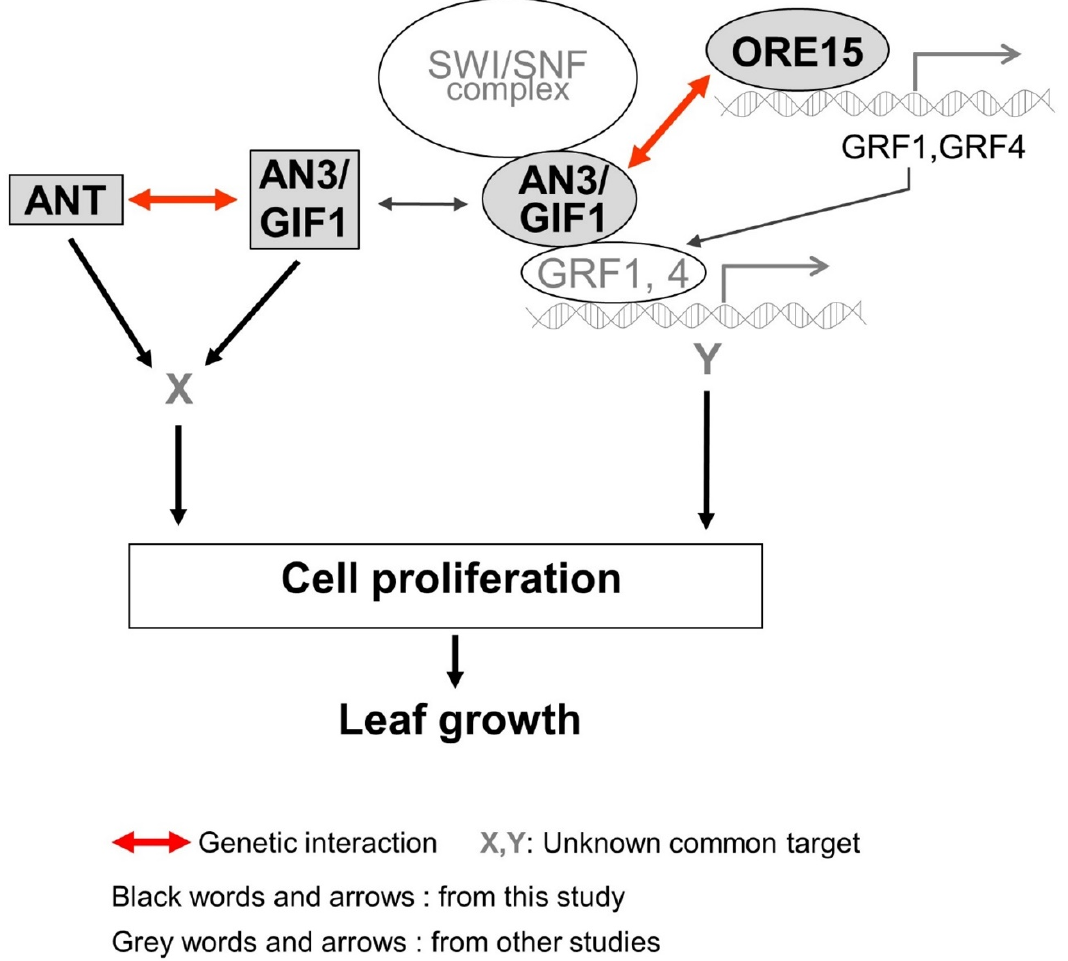
Figure 6. A working model of the genetic interaction between ORE15, AN3, and ANT for cell proliferation regulatory pathway during leaf growth. Two functionally redundant parallel pathways might converge on common nodes, by regulating unknown target X, Y